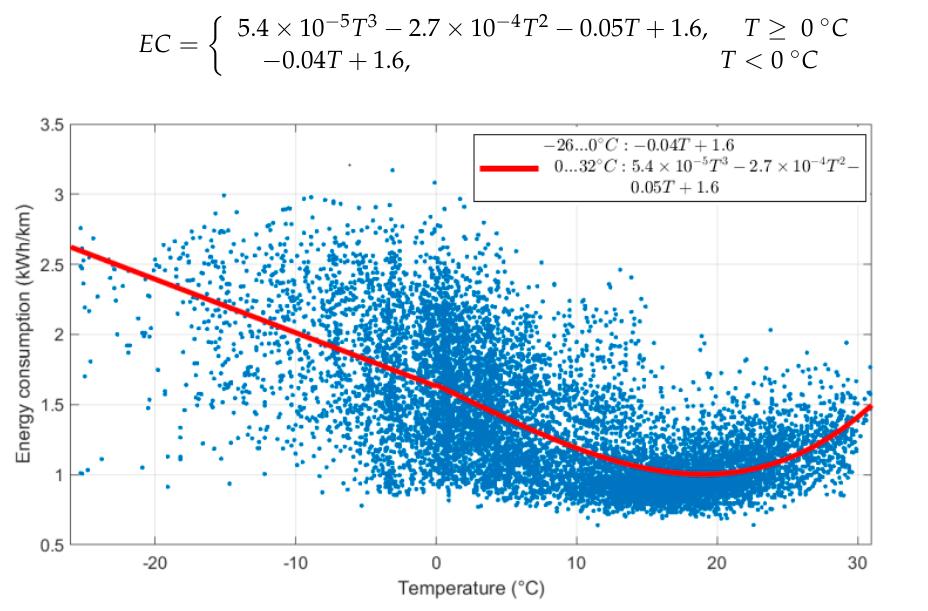
Figure 9. Energy consumption as a function of temperature (blue dots—samples; red line— polynomial curve fit).